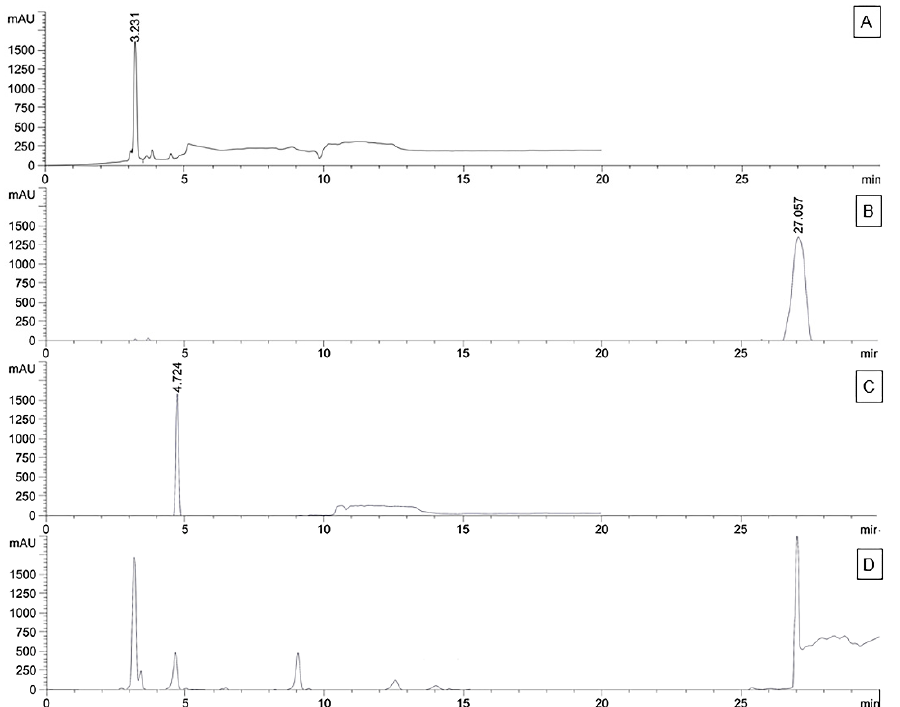
Figure 3. HPLC chromatograms of ( A ) compound 1 , ( B ) compound 2 , ( C ) compound 3 and ( D ) crude extract of CA.